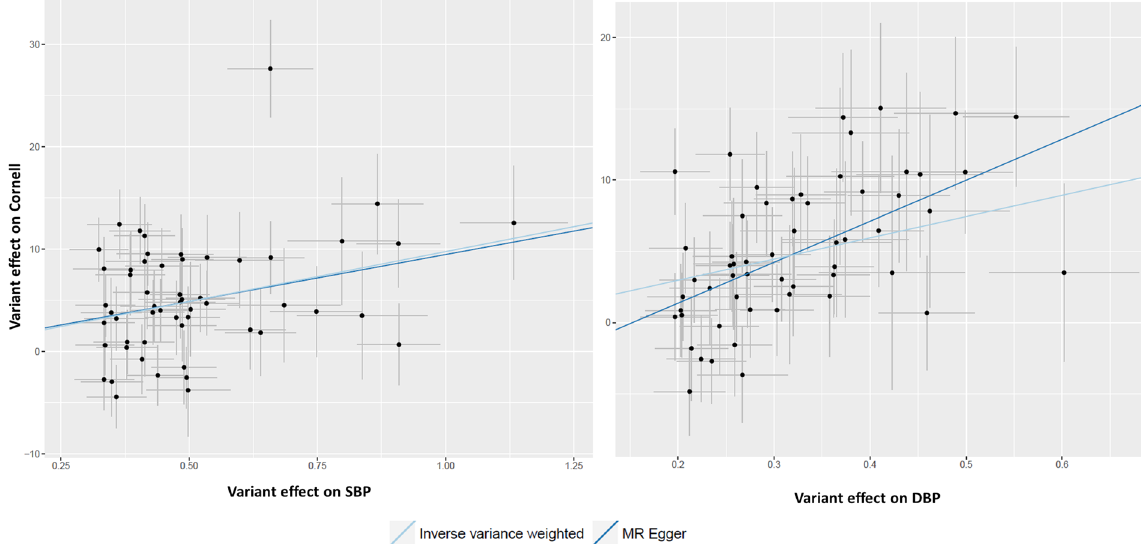
Figure 3. Scatter plots: SBP and DBP associated with ECG Cornell criteria. On the X-axis the variant effects on blood pressure are displayed and on the Y-axis the variant effect on Cornell product. The light blue line is the regression line of the inverse-variance-weighted fixed-effects meta analyses. The dark blue line is the regression line of the MR Egger regression line. DBP = diastolic blood pressure, MR = Mendelian randomization, SBP = systolic blood